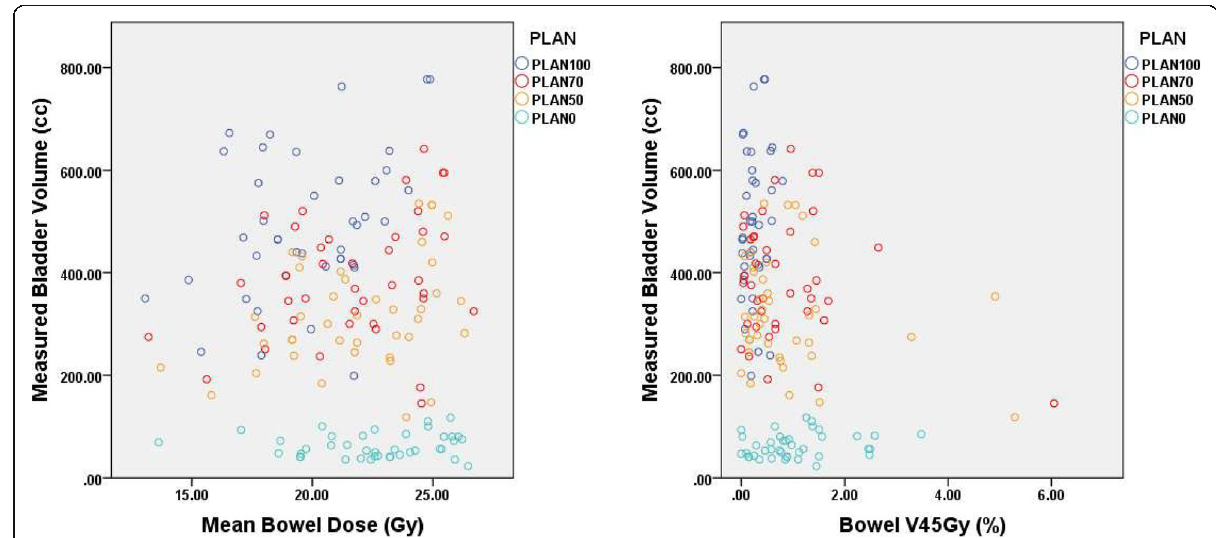
Fig. 3 Scatterplot showing correlation between bladder volumes and corresponding mean dose and V 45 Gy of bowel for different plans